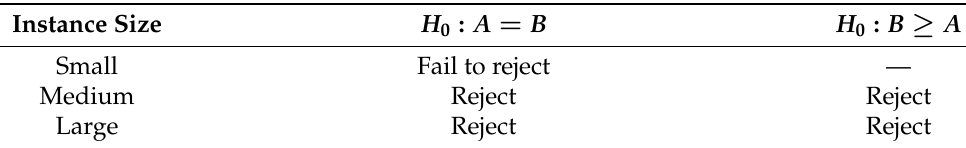
Table 7. Summary of Wilcoxon tests to compare the alternatives of the heuristic.